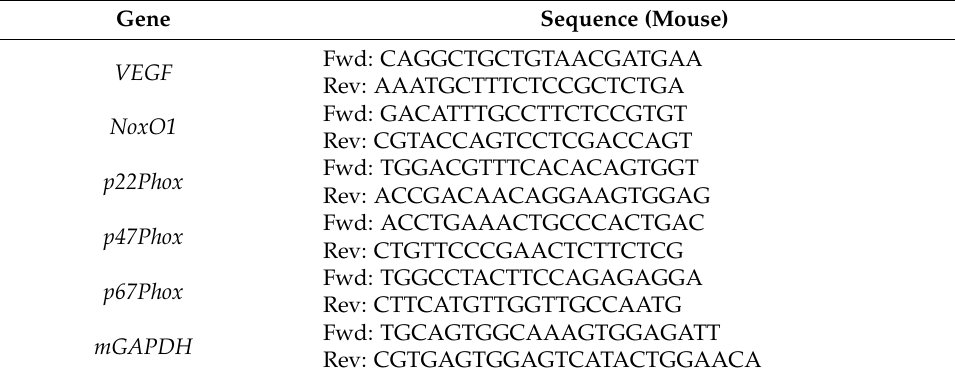
Table 2. Primer sequences for reverse transcription polymerase chain reaction